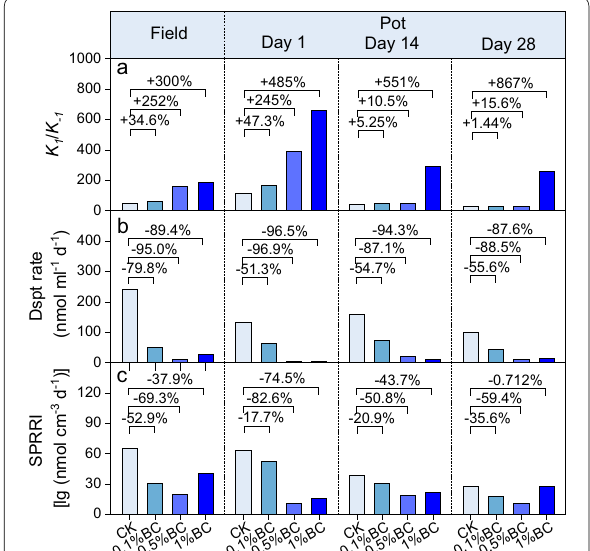
Fig. 4 Variation of K 1 / K -1 , desorption rate, and SPRRI values for four treatments under field and greenhouse pot experiments. CK, 0.1%BC, 0.5%BC, and 1%BC are referred as biochar addition rates at 0, 2.25, 11.25, and 22.5 t ha − 1 , respectively